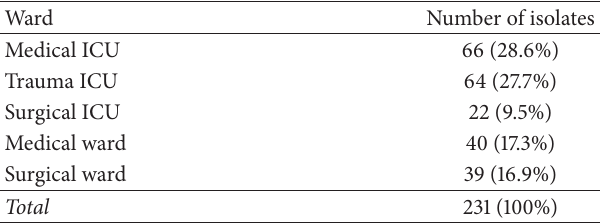
Table 4: Hospital-acquired isolates in different wards.